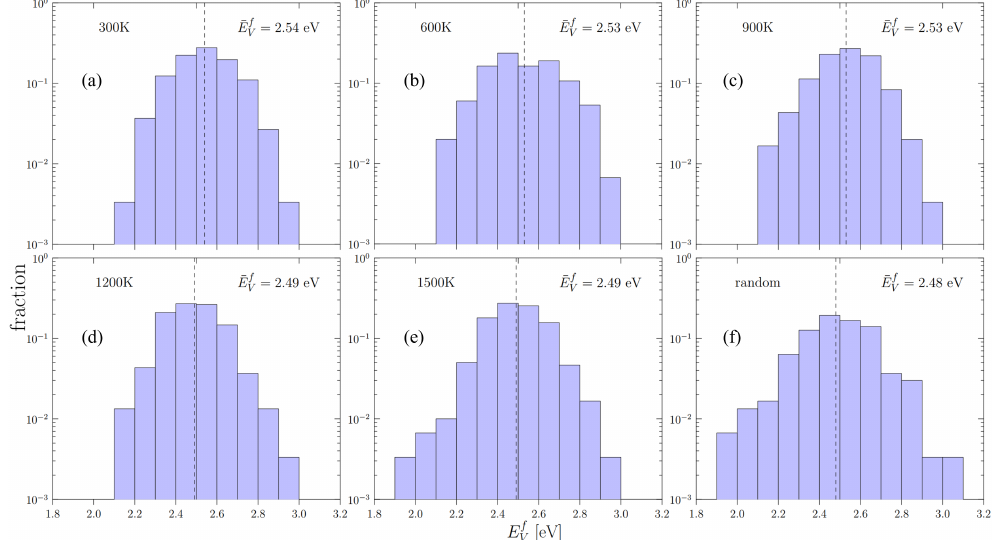
Figure 4. The distributions of vacancy formation energies of: ( a – e ) cells with short range order (annealing temperature from 300 K to 1500 K) and ( f ) the random cell of Nb-Mo-Ta-W. The dashed line shows the position of the statistical average of each